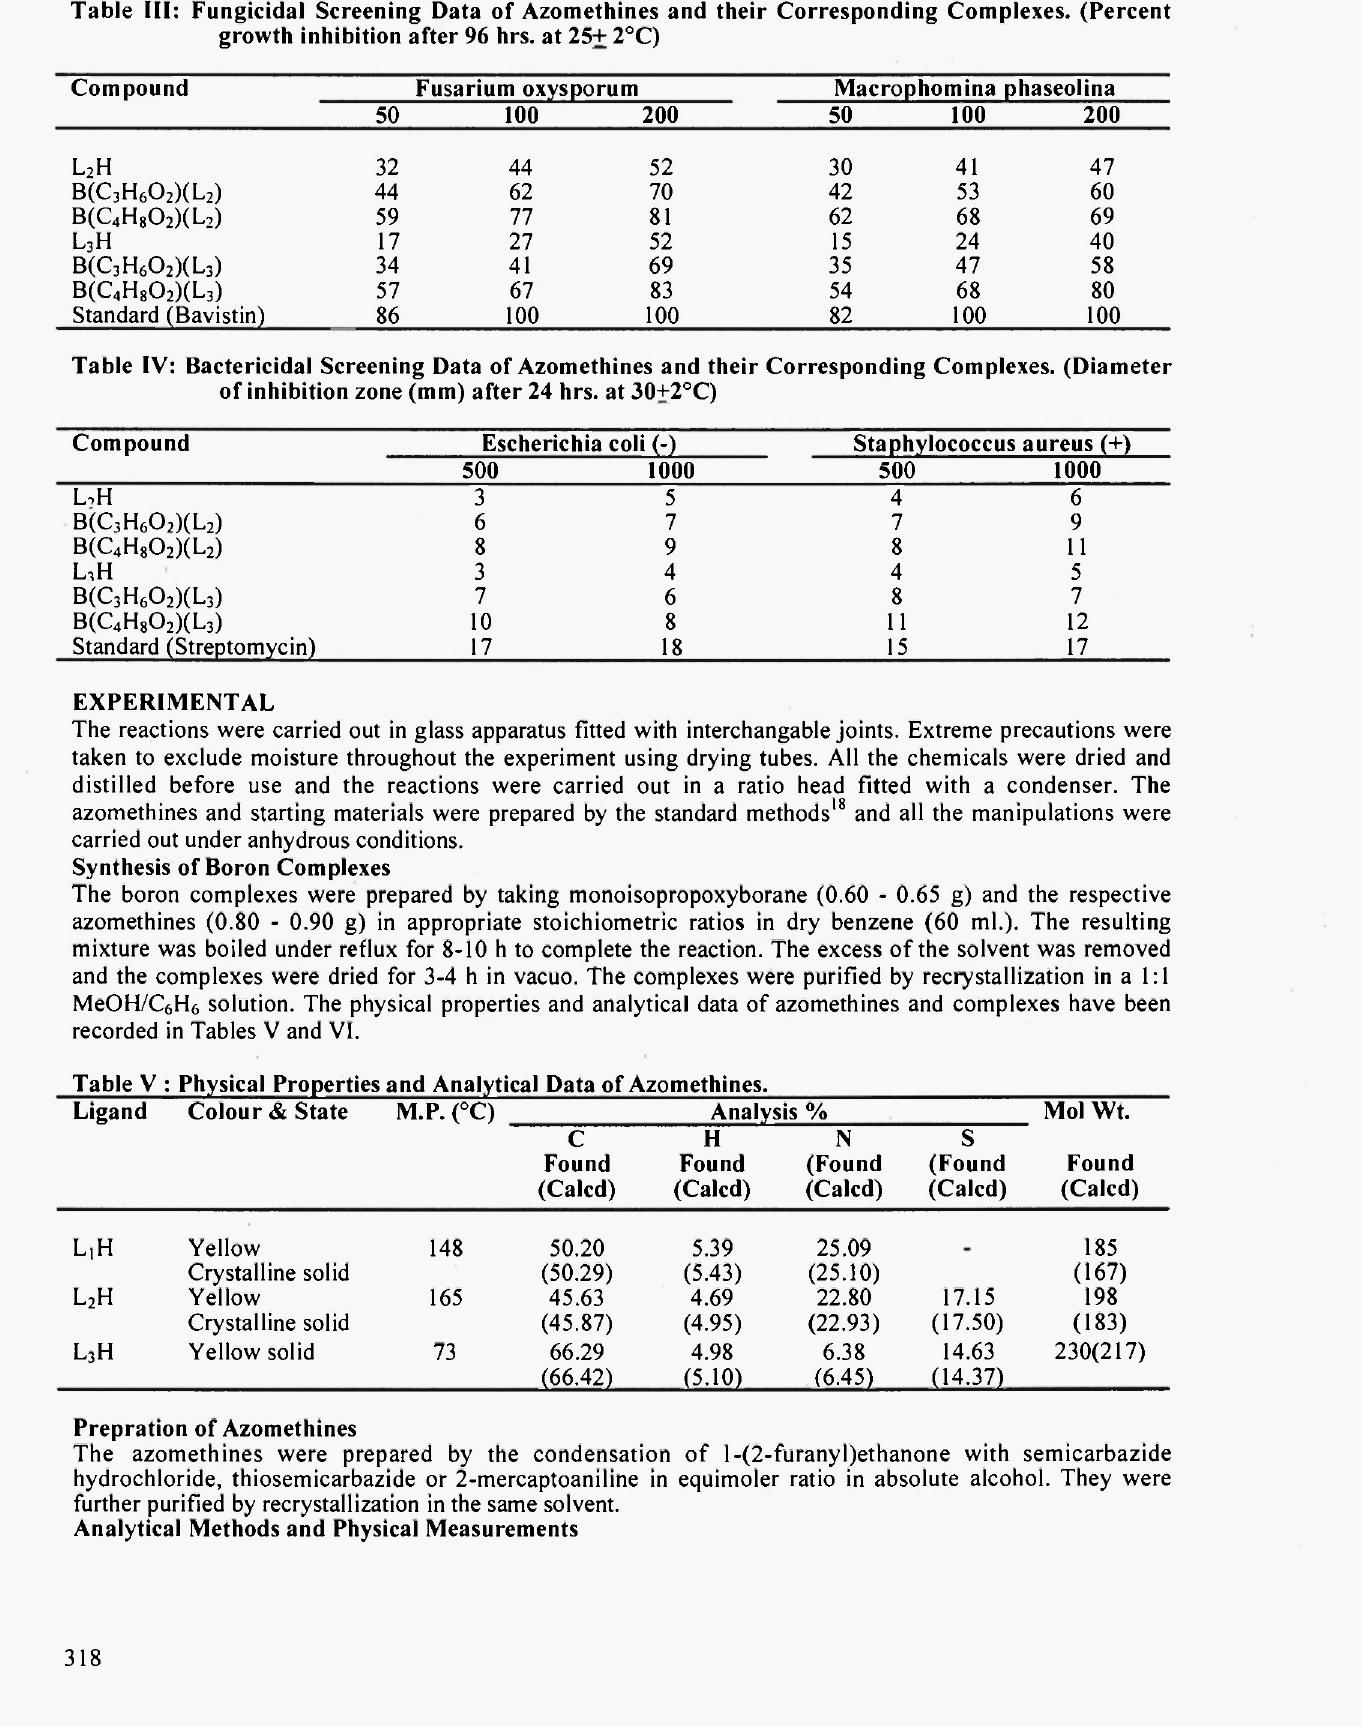
Table III: Fungicidal Screening Data of Azomethines and their Corresponding Complexes. (Percent growth inhibition after 96 hrs. at 25+ 2°C)